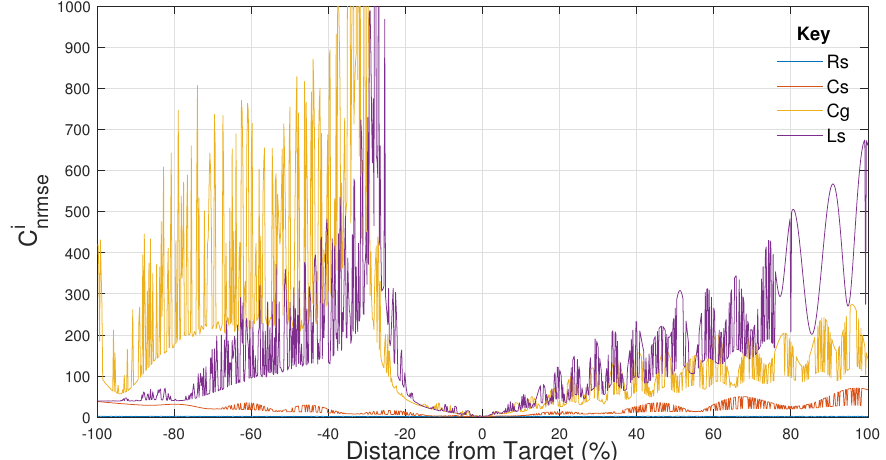
Figure 9. Inferred EMD Cost Function C i nrmse versus Distance from the Target Model Parameter [28]. (© 2023 IEEE. Reprinted, with permission, from EEEIC/I&CPS